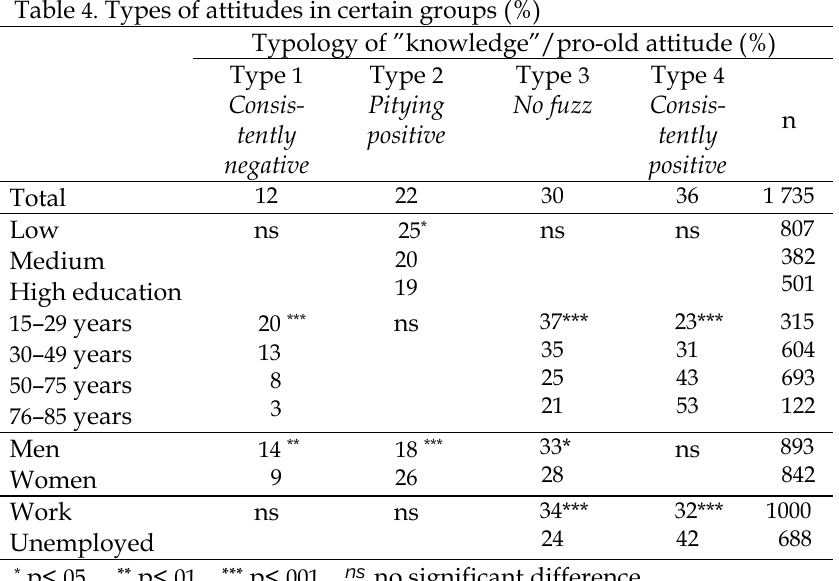
Table 4. Types of attitudes in certain groups (%) Typology of ”knowledge”/pro-old attitude